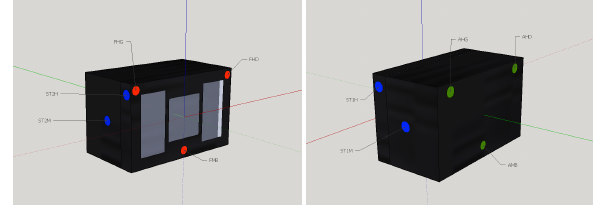
depth map is computed for each acquisition